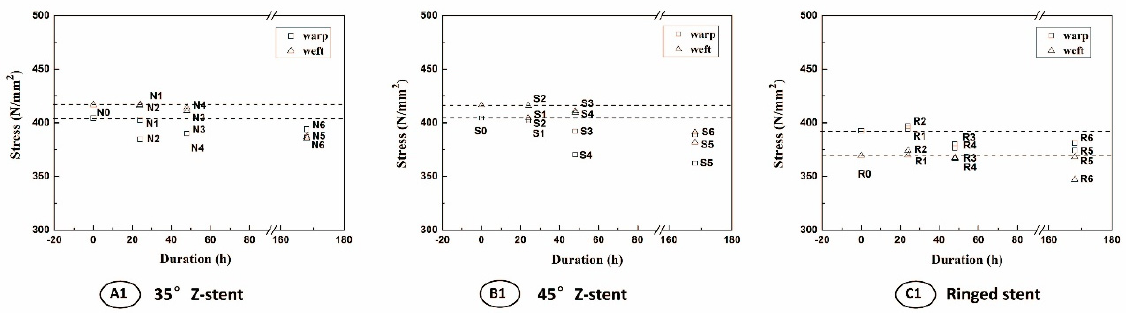
Figure 11. Tensile strength of fibers from the stent ‐ grafts after different test durations. ( A1 ) 35° Z ‐ stent; ( B1 ) 45° Z ‐ stent; ( C1 ) Ringed stent.